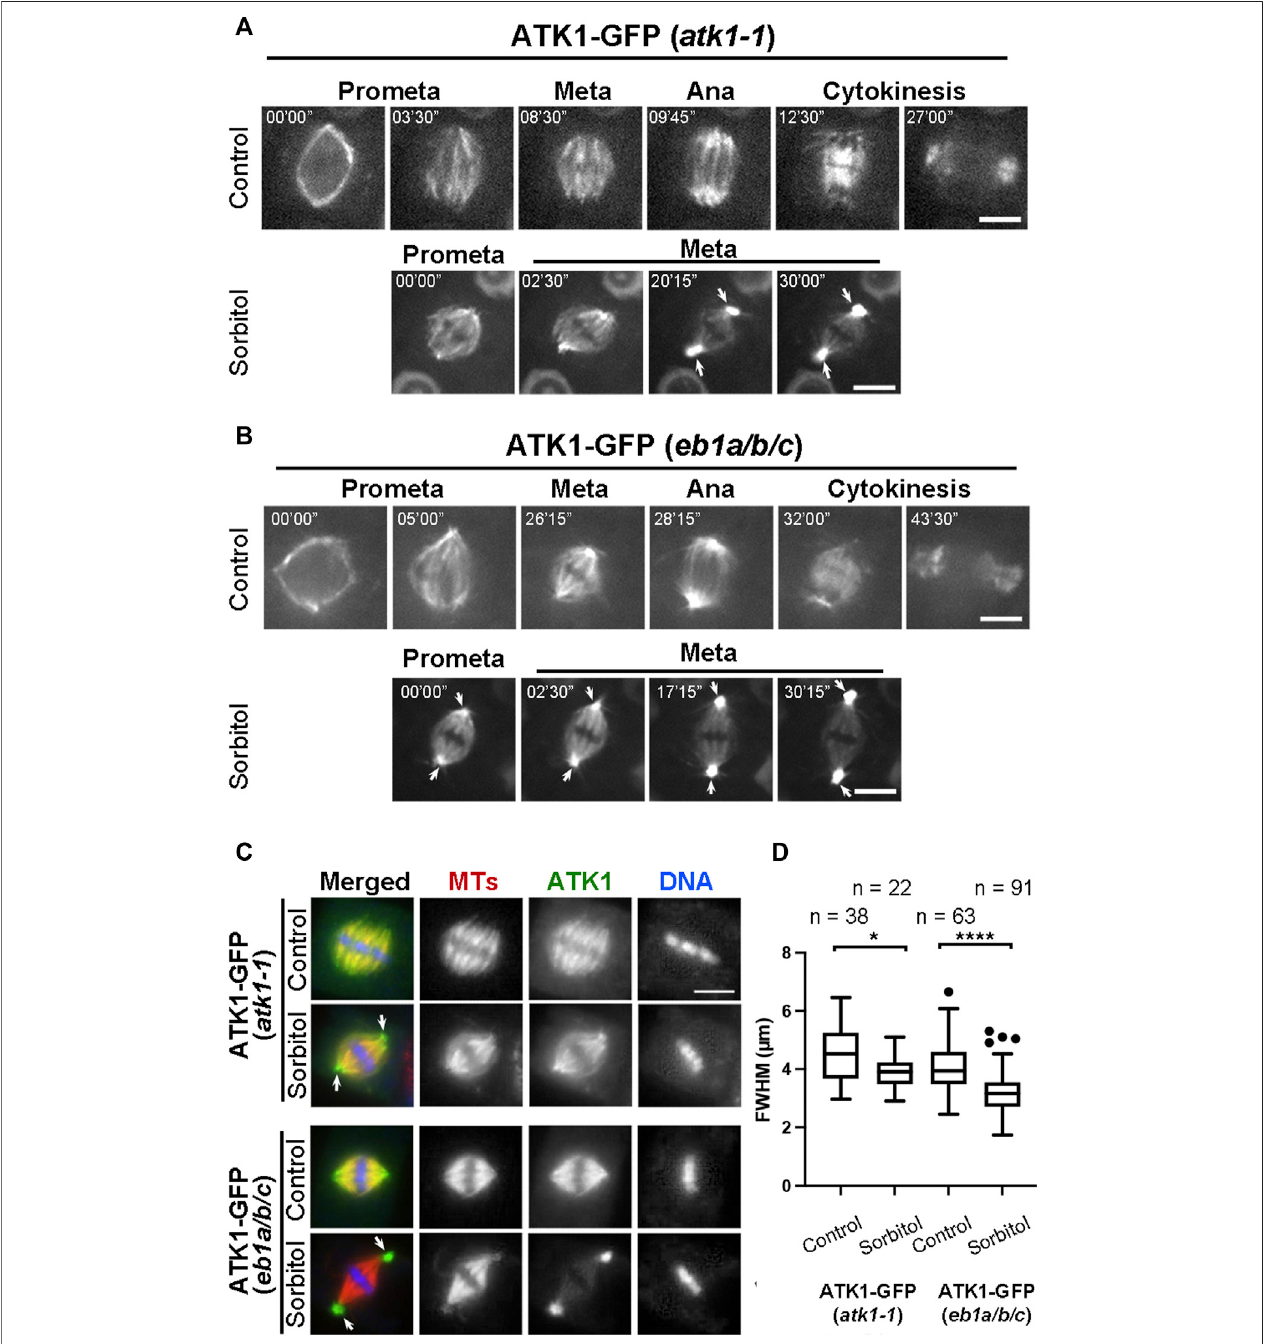
FIGURE4| PolewardaccumulationofATK1-GFPuponsorbitoltreatmentinmitoticcellsof A . thaliana . (A) In atk1-1 cellsexpressingATK1-GFP,sorbitoltreatment induces redistribution of the GFP signal toward spindle poles (arrows), in contrast to the uniform signal along spindle MTs from prometaphase (Prometa) to cytokinesis without sorbitol. (B) Poleward ATK1-GFP accumulation is enhanced in the eb1a/b/c triple mutant. Without sorbitol, ATK1-GFP exhibits biased localization toward spindle poles when compared to the control cell in (A) . GFP signal becomes highly enriched at the poles (arrows) after sorbitol treatment while that in the spindle proper becomes diminished when the cell shows prolonged metaphase. At later stages, ATK1-GFP appears in pseudo-centrosomes at two spindle poles. (C) Comparison of poleward ATK1-GFP accumulation by immuno fl uorescence of both ATK1-GFP and MTs in the atk1-1 rescued plant and the eb1a/b/c mutant background. In the rescued atk1-1 cells, the uniform localization of ATK1-GFP along spindle MTs is replaced by a spindle pole-biased localization pattern of ATK1-GFP after sorbitol treatment (arrows). In the eb1a/b/c mutant background, ATK1-GFP becomes more concentrated toward the poles when compared to the uniform MT signal. The sorbitol treatment leads to the formation of ATK1-GFP-concentrated pseudo-centrosomes (arrows) that are not enriched with MTs. The spindle proper as markedbythekinetochoreMT fi bers hasgreatlydiminished theATK1signal. (D) Quantitativeassessmentofspindle poleconvergencebymeasuring thefullwidth atthe half maximum (FWHM) values of the spindle MT arrays. The difference between the ones by mock (water) and sorbitol treatments is greatly exaggerated inthe eb1a/b/c mutant background. Sample numbers (n) are shown on the top. Scale bars, 5 µm.